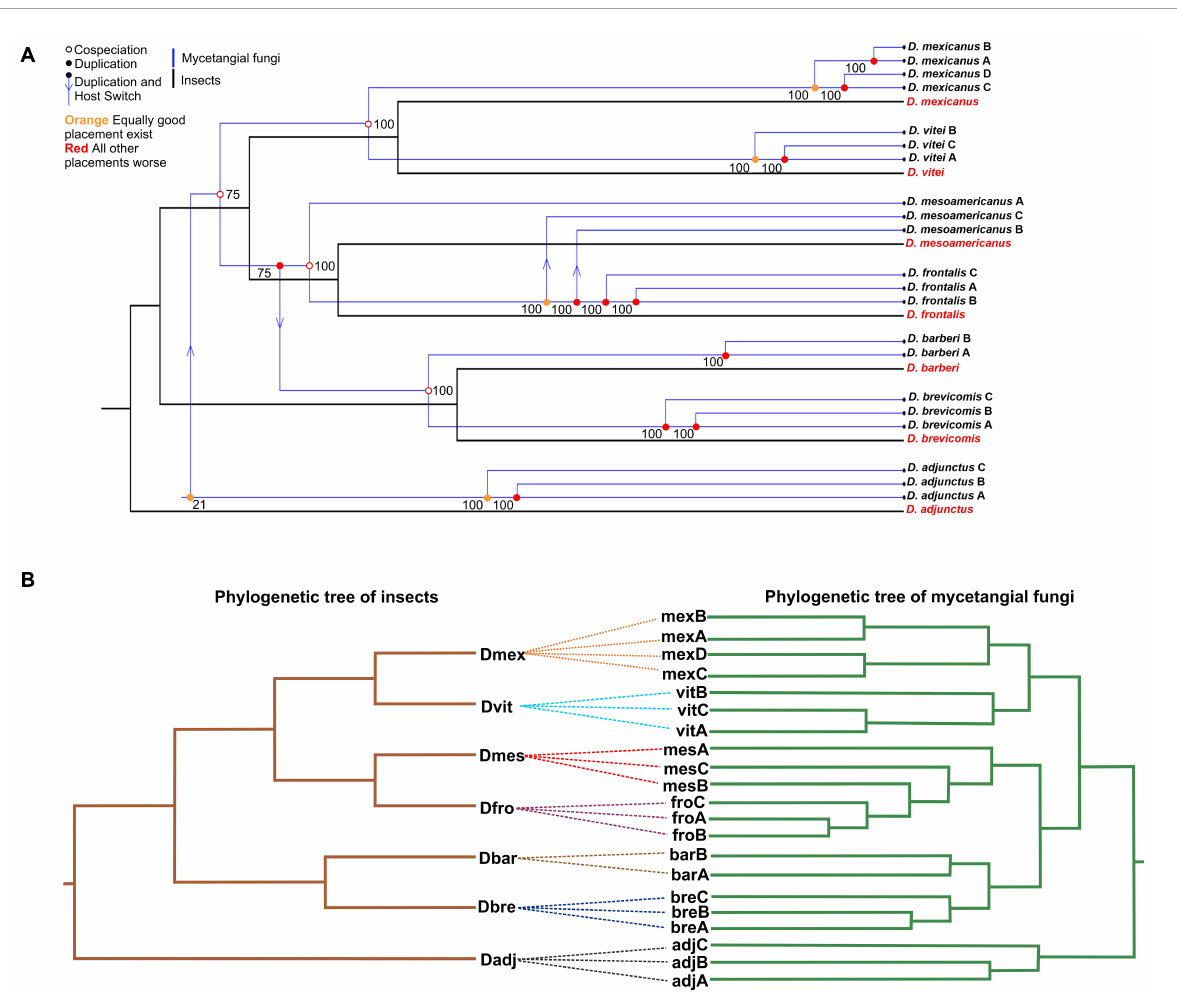
FIGURE3 The tanglegram of fungal assemblages and species of the D . frontalis complex. (A) Topological reconciliation of bark beetles and fungal assemblages. Four cospeciation events were found, the first between D . mexicanus and D . vitei ; the second between D . mesoamericanus and D. frontalis ; the third between groups D . mexicanus + D . vitei and D . mesoamericanus + D . frontalis ; and the last between D . barberi and D . brevicomis . Four duplication and host switch events were detected between D . frontalis and D . mesoamericanus (2), between groups D . mesoamericanus + D . frontali s and D . barberi + D . brevicomis (1), and the last between D . adjunctus and the group of D . mexicanus + D . vitei + D . mesoamericanus + D . frontalis (1). The reconciliation of topologies ( p = 0.01) and association between distance matrices (Mantel test r = 0.7093, p = 0.003) were significant. (B) ML-phylogeny from the species of the D . frontalis complex inferred using mtDNA COI sequence (AF60001. 1 D . adjunctus , AF06999.1 D . barberi , AF068002.1 D . brevicomis , AF067986.2 D . frontalis , AF067988.1 D . mexicanus , KT364536.1 D . mesoamericanus , KT364538.1 D . vitei ). The model best was GTR + I sensu Akaike criterion (k = 20, − Ln = 3018.98366, AIC = 6077.96732). Bootstrap values are shown upper nodes. D . adjunctus was used as outgroup. Dendrogram of fungal assemblages built using UPGMA and Bray-Curtis dissimilarity